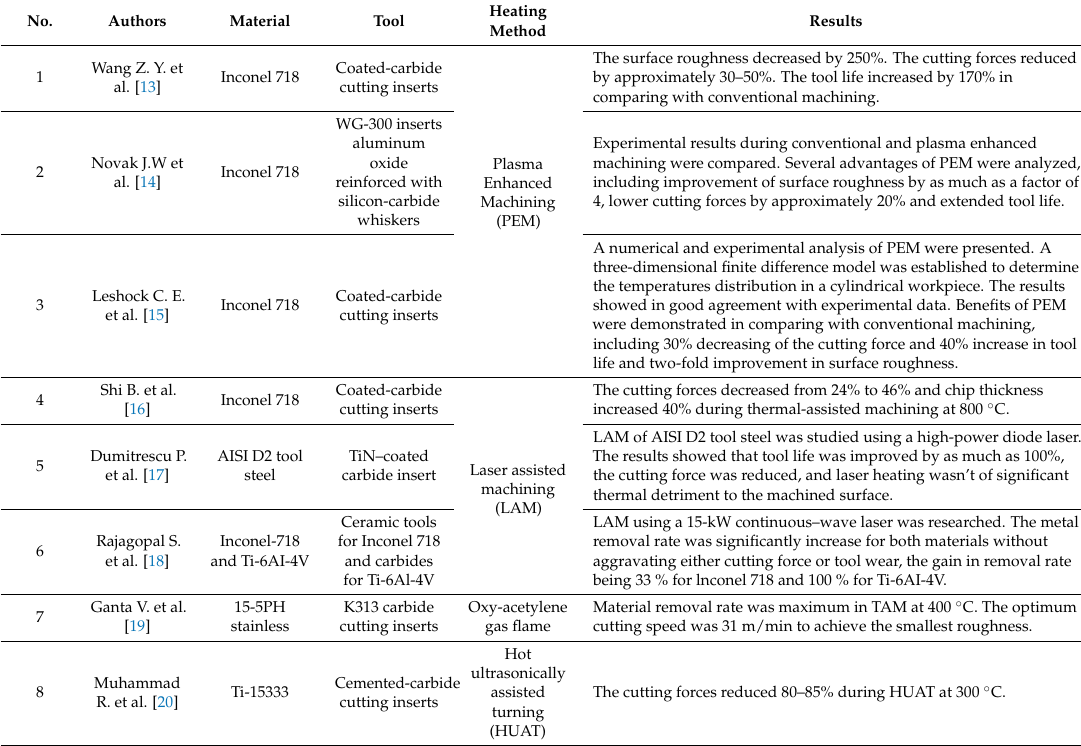
Table 1. Summary of previous studies during thermal-assisted